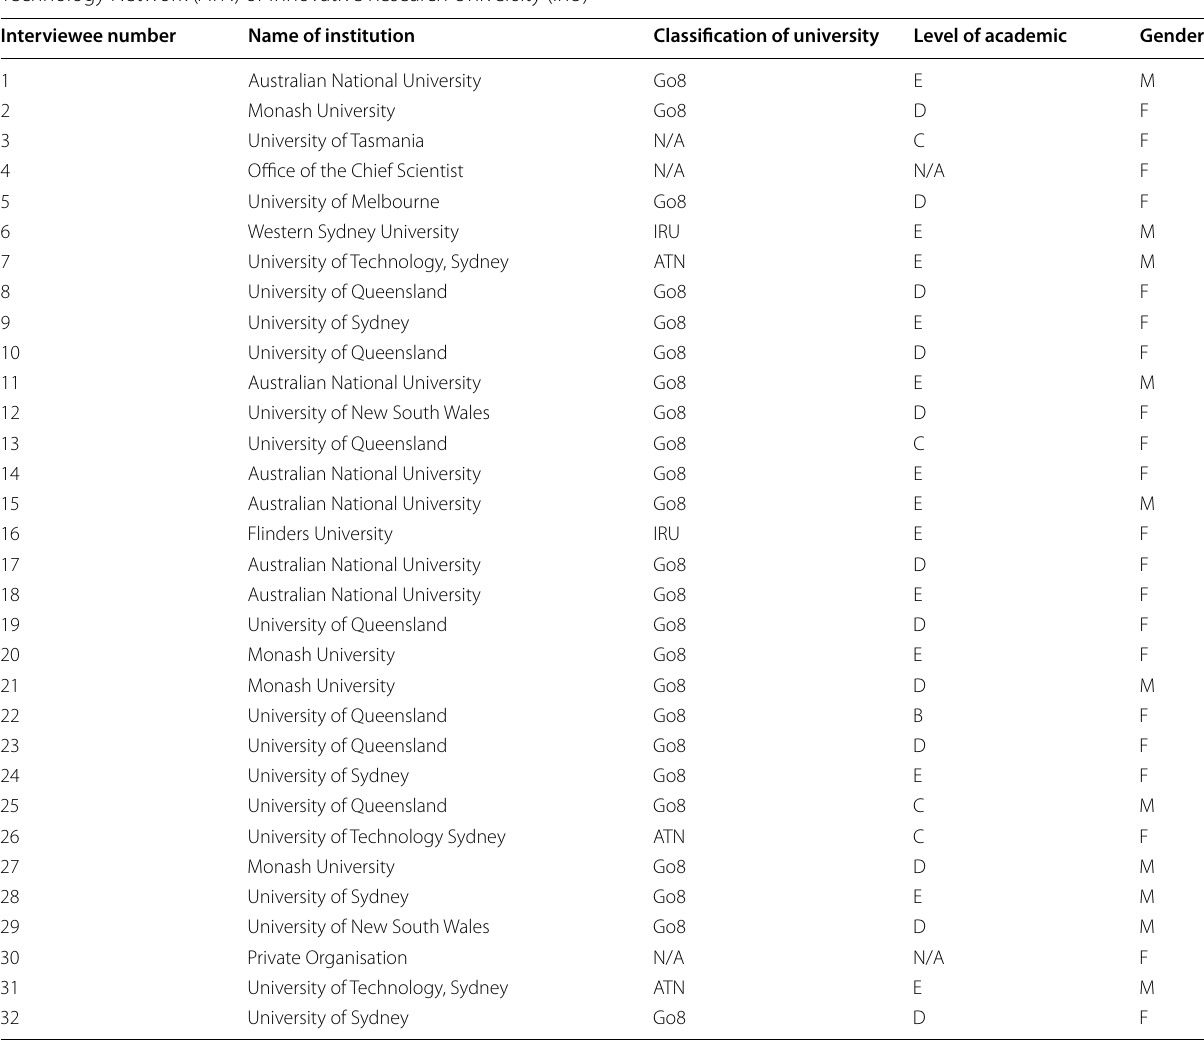
Table 1 Number and identification of interviewees from universities classified as research intensive (Group of Eight, Go8),